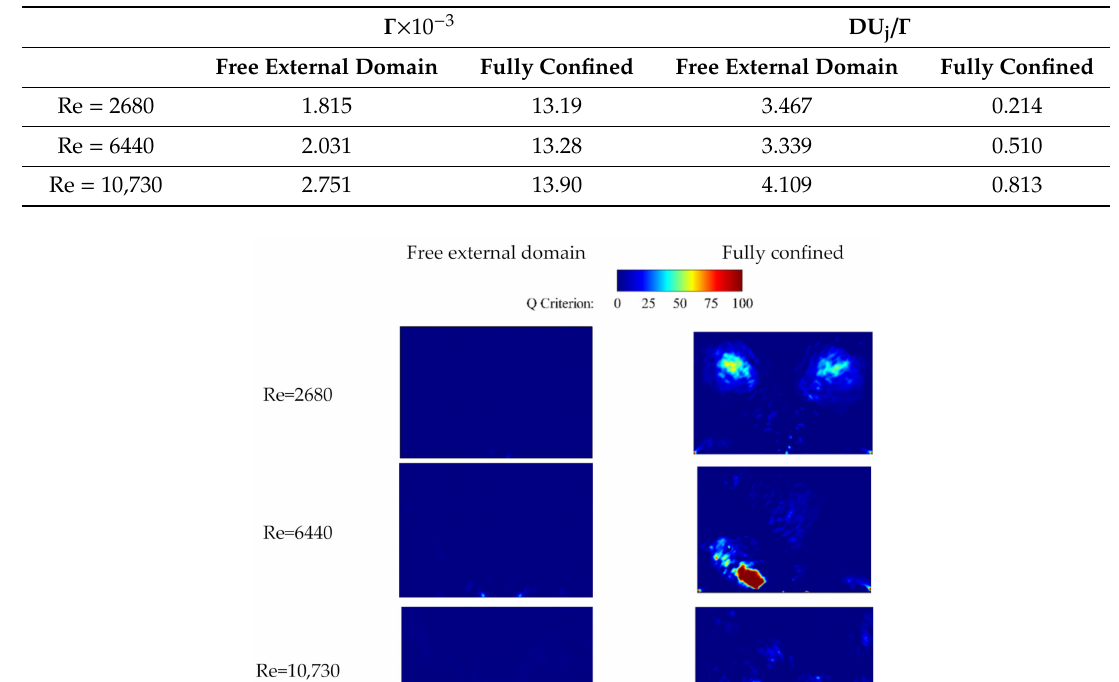
Table 1. Circulation ( Γ ) and DU j / Γ over the area with positive Q-criterion (Q > 0).